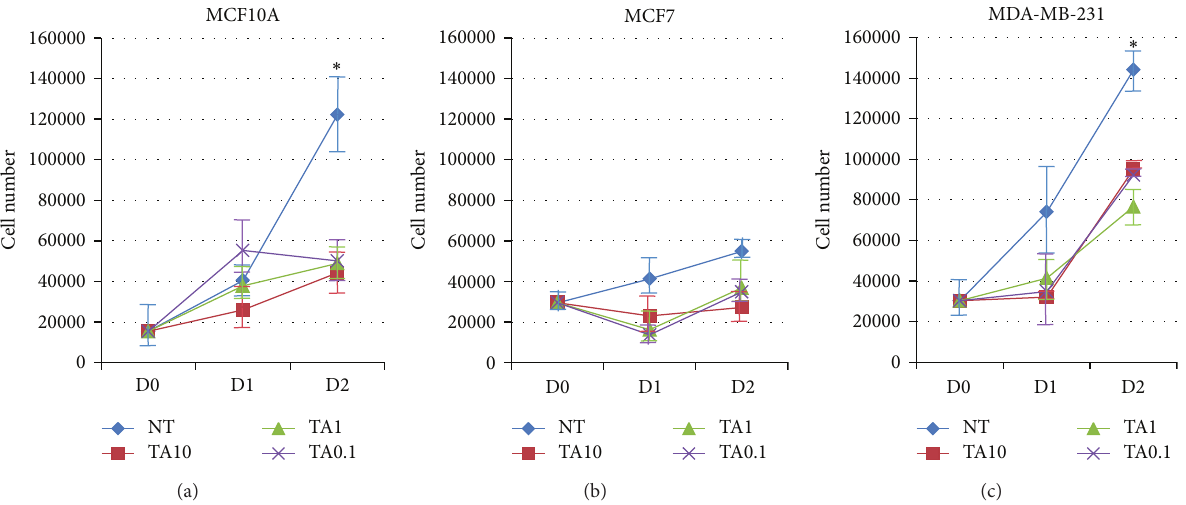
Figure 3: Tannic acid treatment affects cell numbers. Three human breast cell lines (a) MCF10A, (b) MDA-MB-231, and (c) MCF7 were treated with 10%, 1.0%, and 0.1% TA cross-linked beads for 24 and 48h. The remaining cells were counted. 𝑛 = 3 , ∗ 𝑃 < 0.02 , and error bars=SE. NT: no treatment.